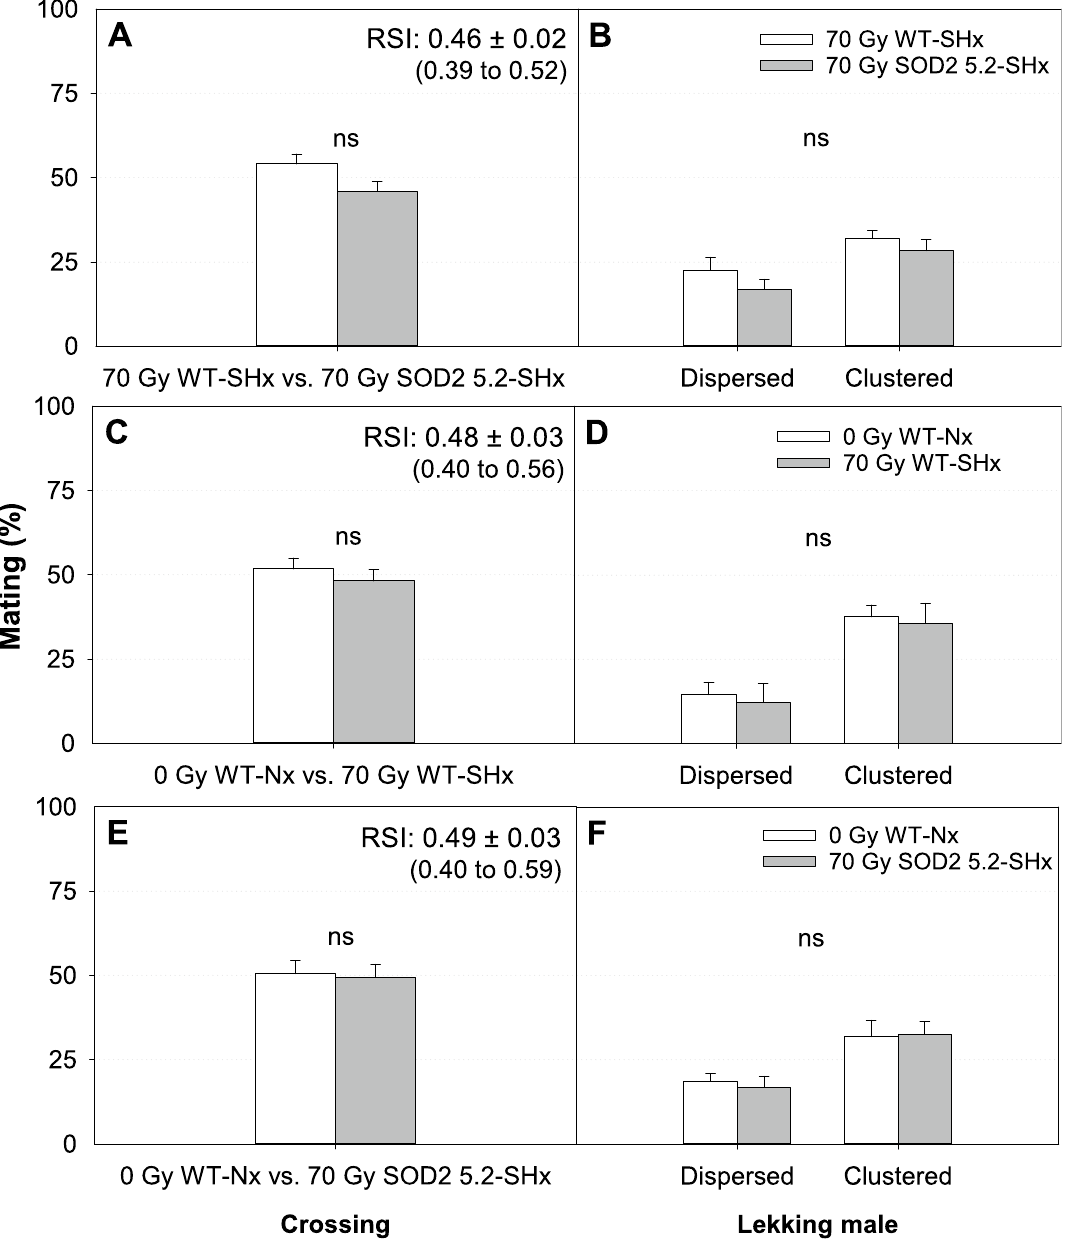
Figure 6. Mean mating success (SE) and positioning of lekking Anastrepha suspensa males treated under severe hypoxia (SHx) in sexual competitiveness tests with low male: female ratio (50 males: 25 females). ( A ) Proportion of matings with WT females achieved by irradiated WT (70 Gy WT-SHx) and irradiated SOD2 5.2 (70 Gy SOD2 5.2-SHx) males. ( B ) Distribution of dispersed and clustered males within leks from matings achieved by 70 Gy WT-SHx and 70 Gy SOD2 5.2-SHx individuals. ( C ) Proportion of matings obtained by non-irradiated WT (0 Gy WT-Nx) and 70 Gy WT-SHx males competing for the same females. ( D ) Distribution of dispersed and clustered males within leks from matings achieved by 0 Gy WT-Nx and 70 Gy WT-SHx individuals. ( E ) Proportion of matings obtained by 0 Gy WT-Nx and 70 Gy SOD2 5.2-SHx males competing for the same WT females. ( F ) Distribution of dispersed and clustered males within leks from matings achieved by 0 Gy WT-Nx and 70 Gy SOD2 5.2-SHx individuals. Graphs marked with ‘ns’ indicates no statistically significant difference for either logistic regression or MANOVA models ( P > 0.05). RSI = ( ♂ SOD2 5.2 × ♀ WT)/( ♂ SOD2 5.2 × ♀ WT) + ( ♂ WT × ♀ WT). Figures were created using Sigma Plot (SigmaPlot for Windows version